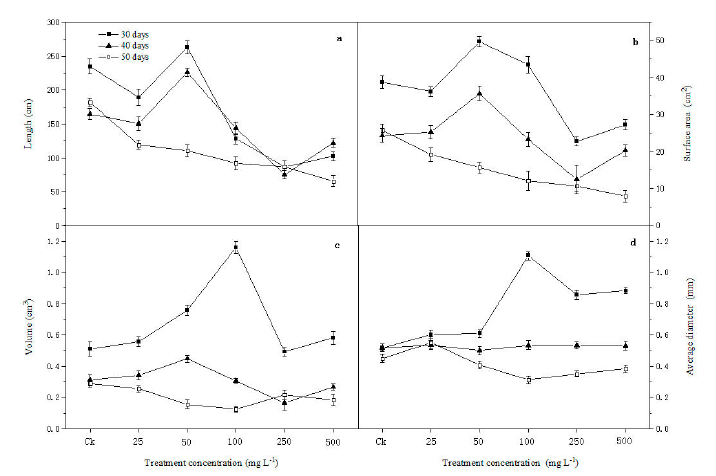
Figure 3. Root morphology of L. olgensis fine roots with different concentrations of graphene (mean ± 1 S.D., n = 3). ( a ): length; ( b ) surface area;( c ): volume; and ( d ): average diameter.